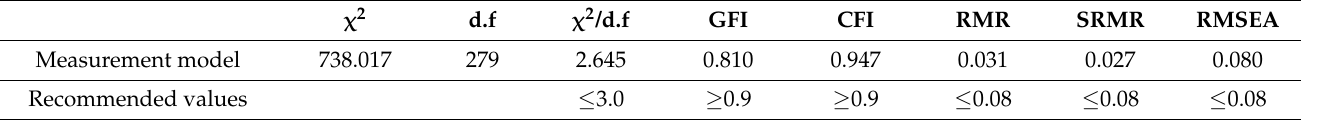
Table 6. Results of fit indices for CFA.